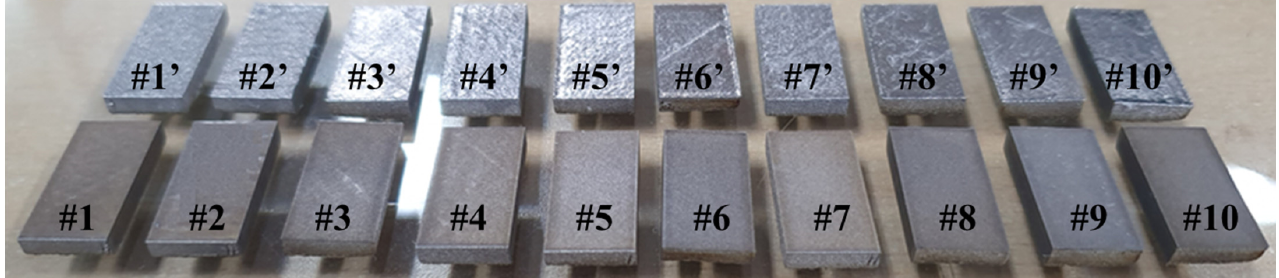
Figure 1. Photographic image of the additive manufacturing (AM)